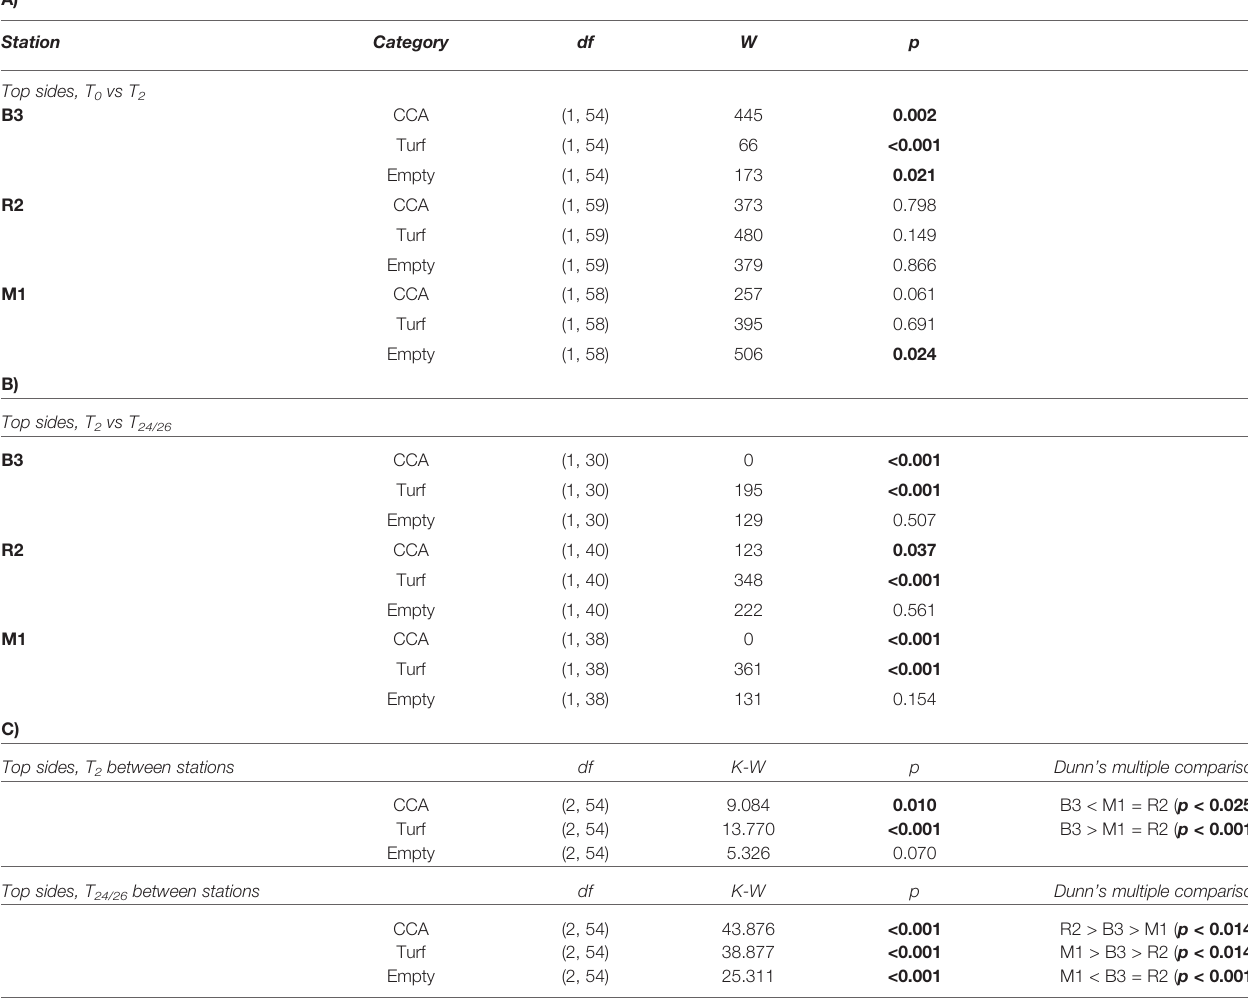
TABLE 2 | Statistical data on CCA, turf and empty cover on the top sides of